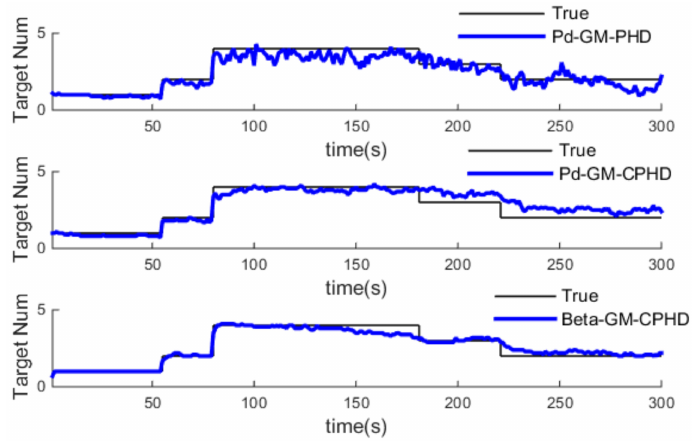
Figure 12. Comparison of target number estimation in clutter intensity κ k = 5.